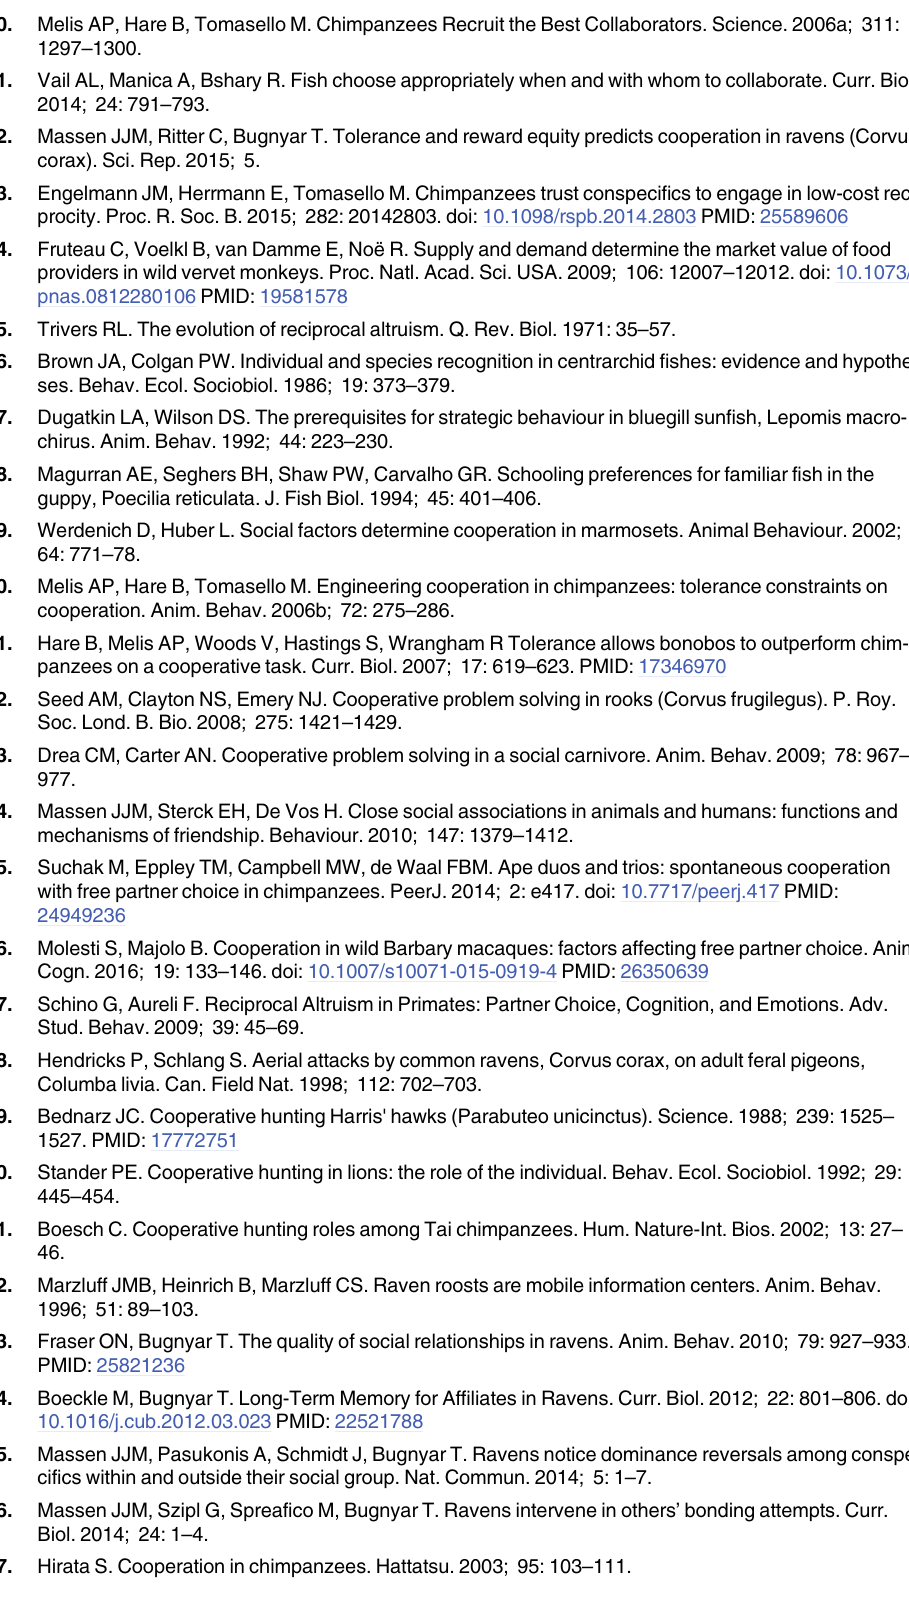
PLOS ONE | DOI:10.1371/journal.pone.0156962 June 10,